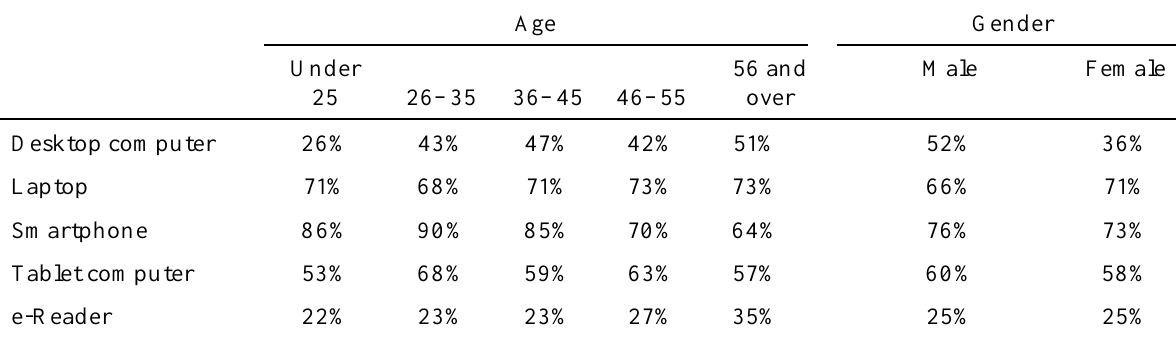
Undergraduate Access to